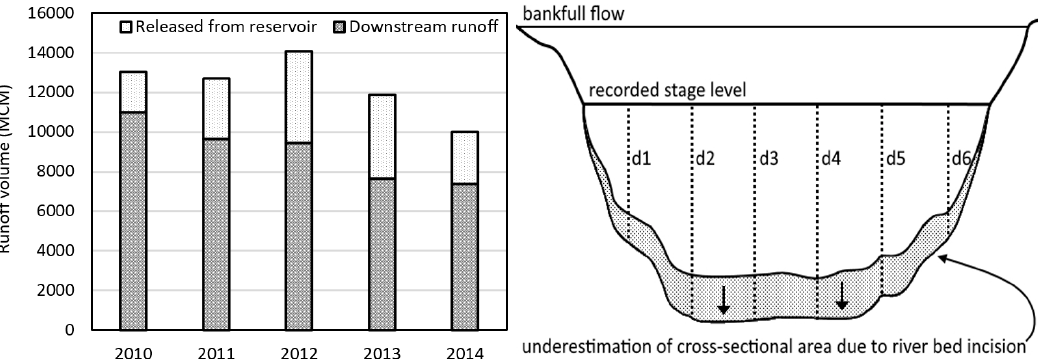
Figure 5. The decreasing trend in observed runoff volume at the Embamadre station (RK100) (left) potentially indicates an underestimated cross-sectional area caused by dam-induced river bed degradation, as the stage–discharge curve has not been updated after dam implementation (right) (Data source: [39,49], own conceptual diagram).